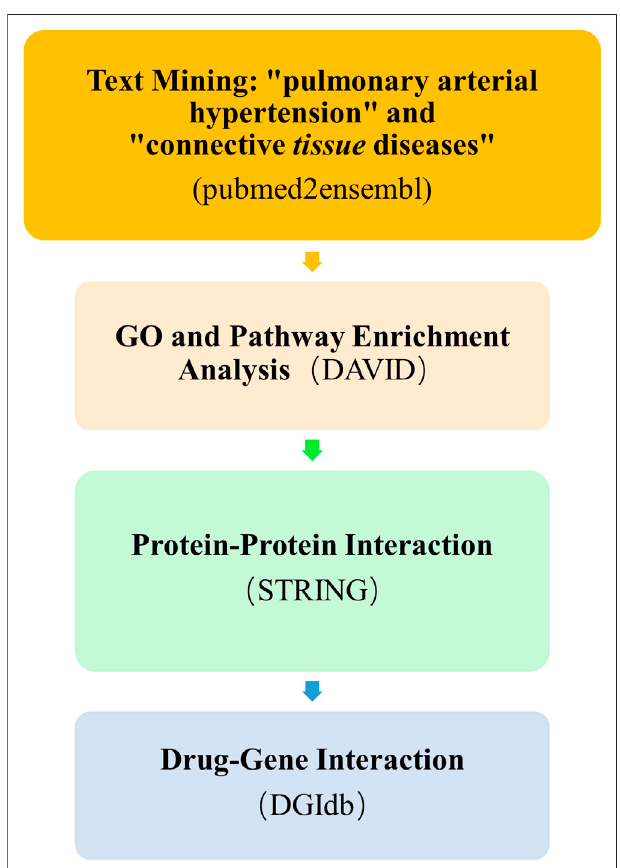
FIGURE 1 | Overall text mining strategy. pubmed2ensembl was used to identifyconnective tissuedisease – associated pulmonary arterial hypertension (CTD-PAH) – relatedgenesets,andtheoverlappinggenesofthetwogenesets were analyzed for enrichment by DAVID. The protein – protein interaction network of the overlapping genes and the enriched candidate genes were shown using STRING. The fi nal enriched candidate genes for further analysis of drug – gene interactions by DGIdb to determine dugs with potential therapeutic effects of CTD-PAH. GO, Gene Ontology; DGIdb, Drug Gene Interaction